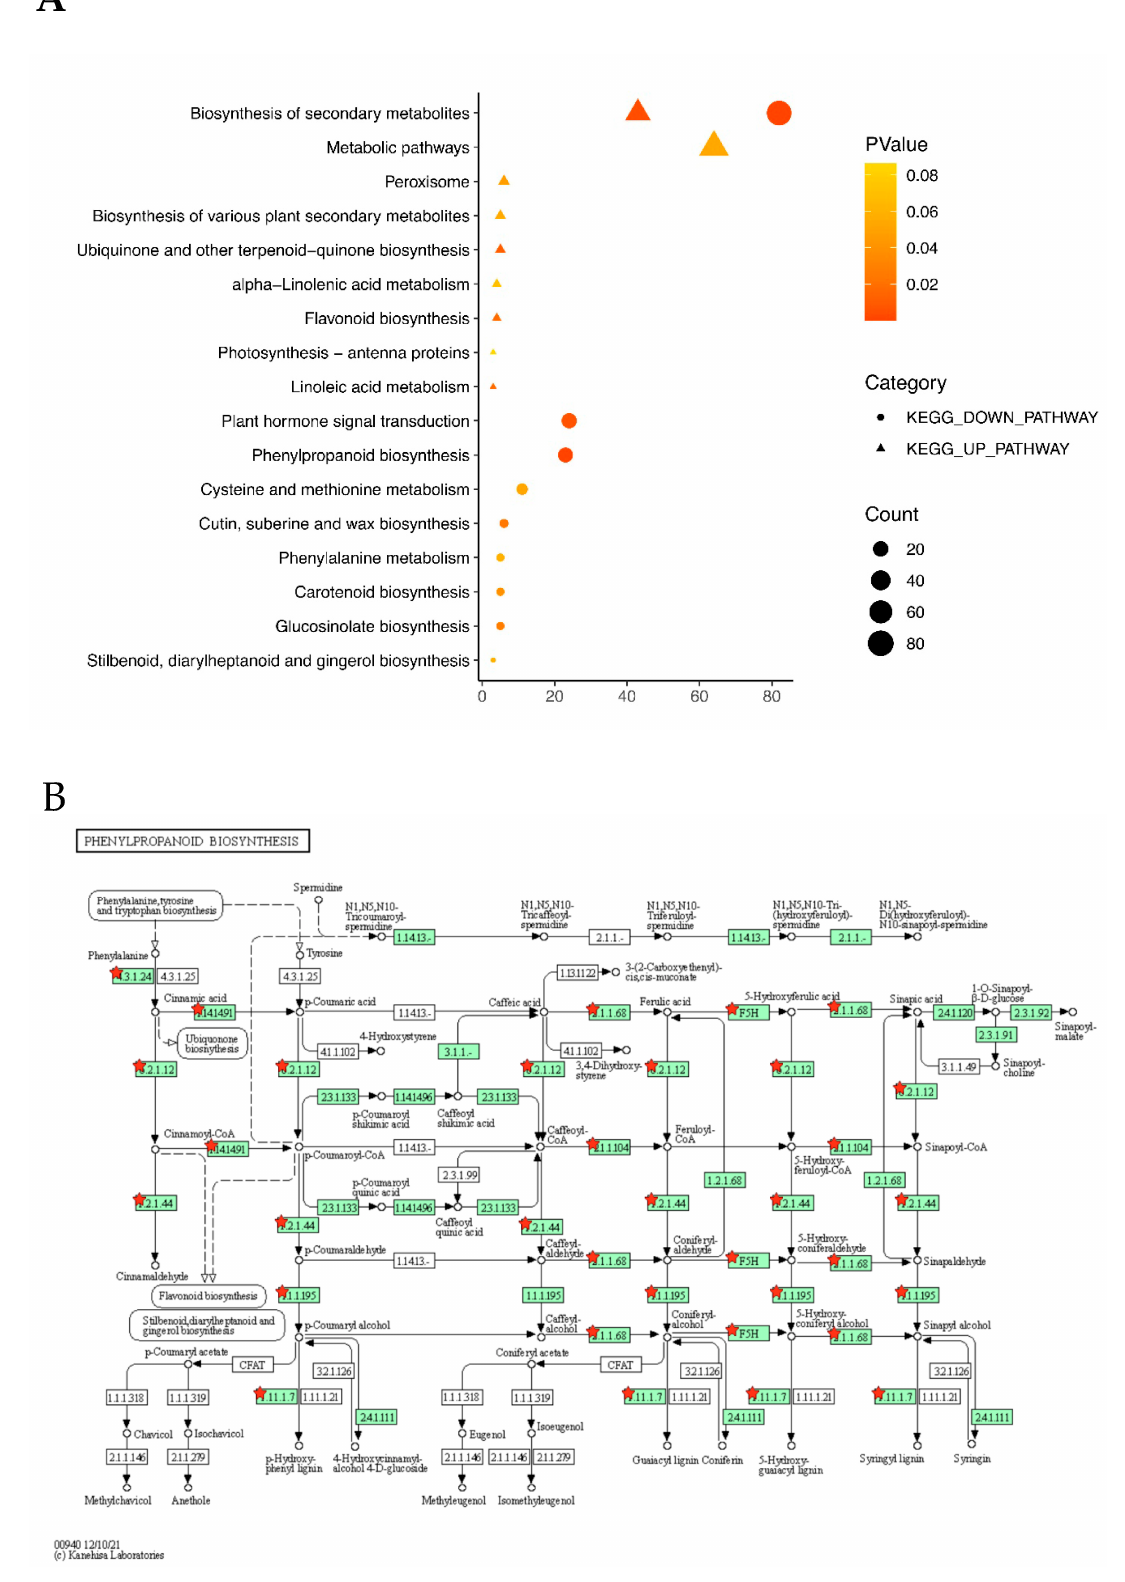
Figure 6. KEGG pathway enrichment analysis of differentially expressed genes (DEGs) identified between low salt (LS) treatment and no salt control (CK) in two Brassica napus varieties (CH336 and Brutor). ( A ). KEGG pathways of DEGs in TOTAL_LS/CK group. The triangle and circle indicate the up- and down-regulated KEGG pathways, respectively. The pa tt ern size means the number of DEGs